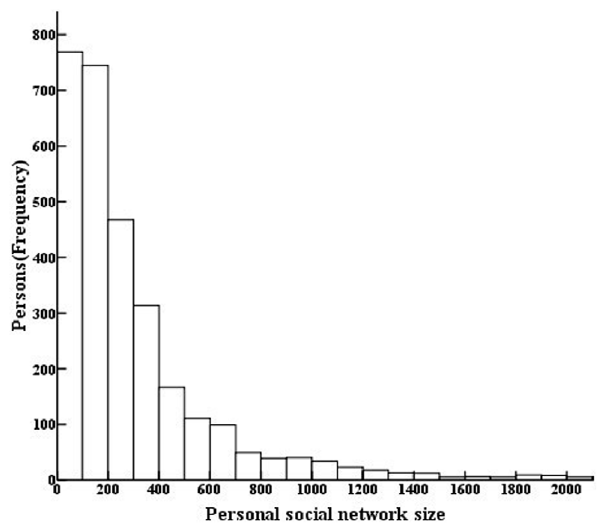
Figure 1. Distribution of social network size, Chongqing, China (2011). (Instances of c more than 2,000 are not shown directly in Figure 1.).